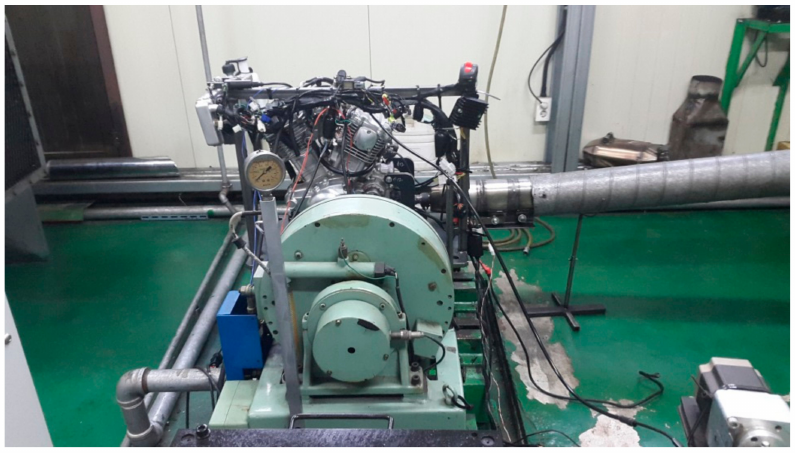
Figure 2. The experimental